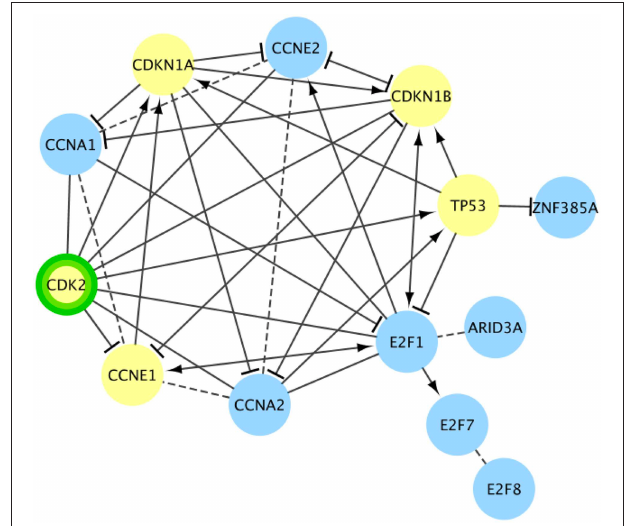
FIGURE 4 | Cancer pathway gene set targeted only by natural products for a cancer driver target. Another Reactome functional interaction network ( TP53 Regulates Transcription of Genes Involved in G1 Cell Cycle Arrest ) targeted only by NPs at < 100nM (green border). No FDA-approved cancer drugs target this pathway with < 100nM evidence. Cancer drivers are shown in yellow. In this pathway the NP target is also a cancer driver. Dashed lines are predicted